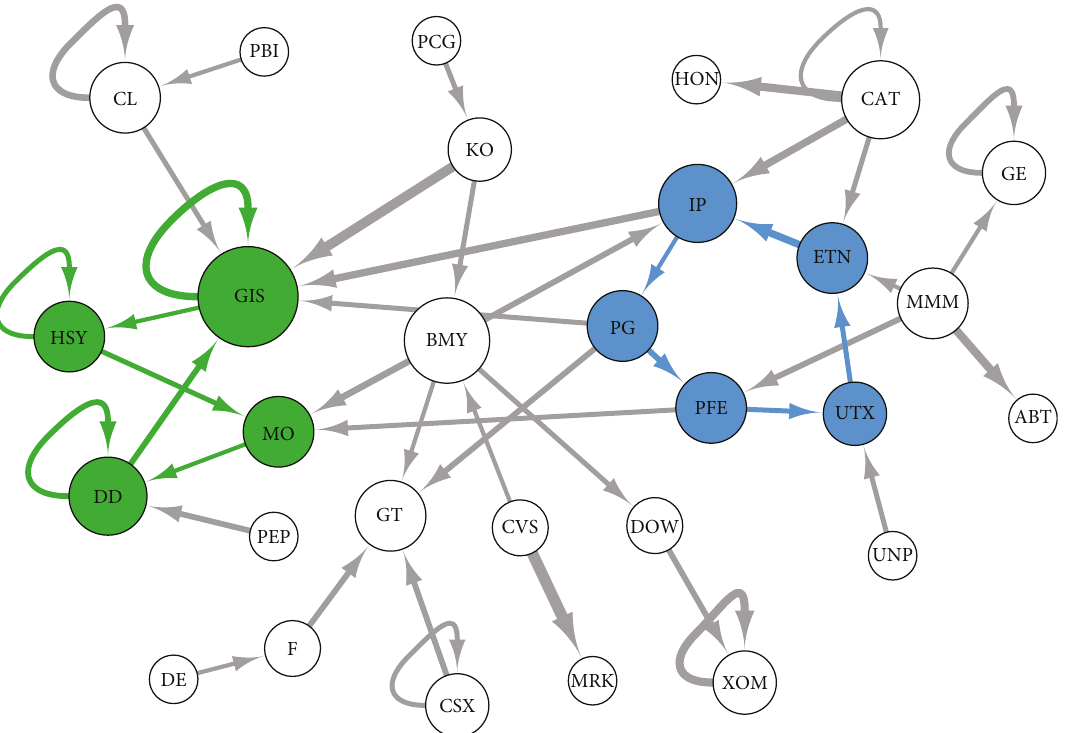
Figure 2: The causality network of the U.S. stock market estimated in the period 1992 – 1994, showing only nodes connected to the main component. Two strongly connected components and the edges within are marked in green and blue. The network was visualized in the Cytoscape software environment